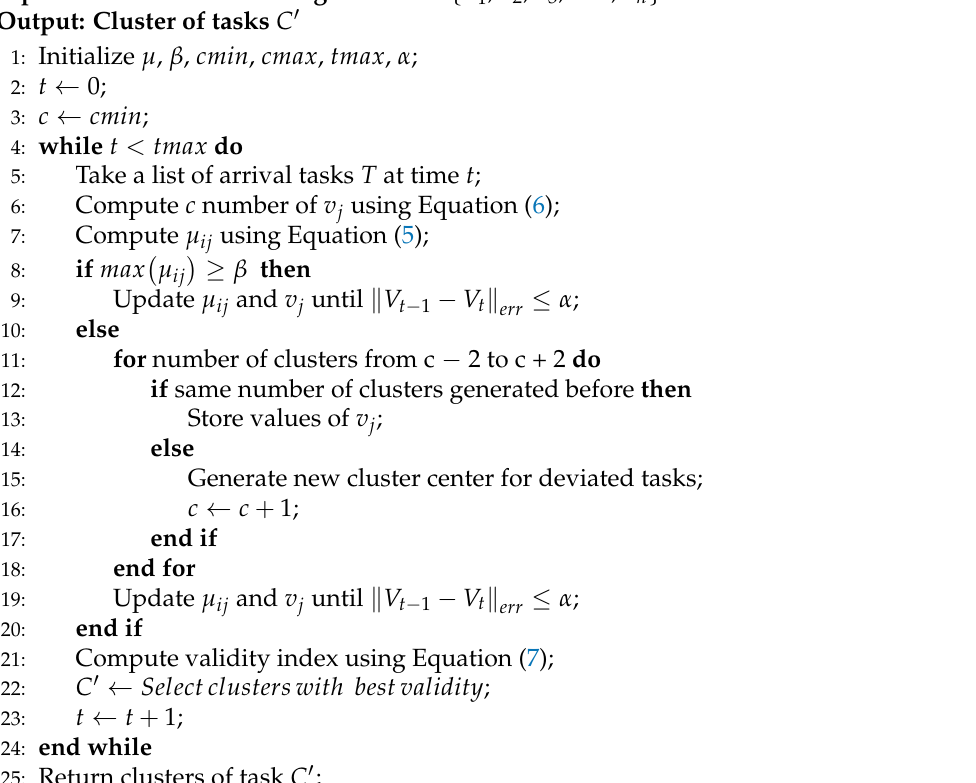
Algorithm 1 dFCM for task